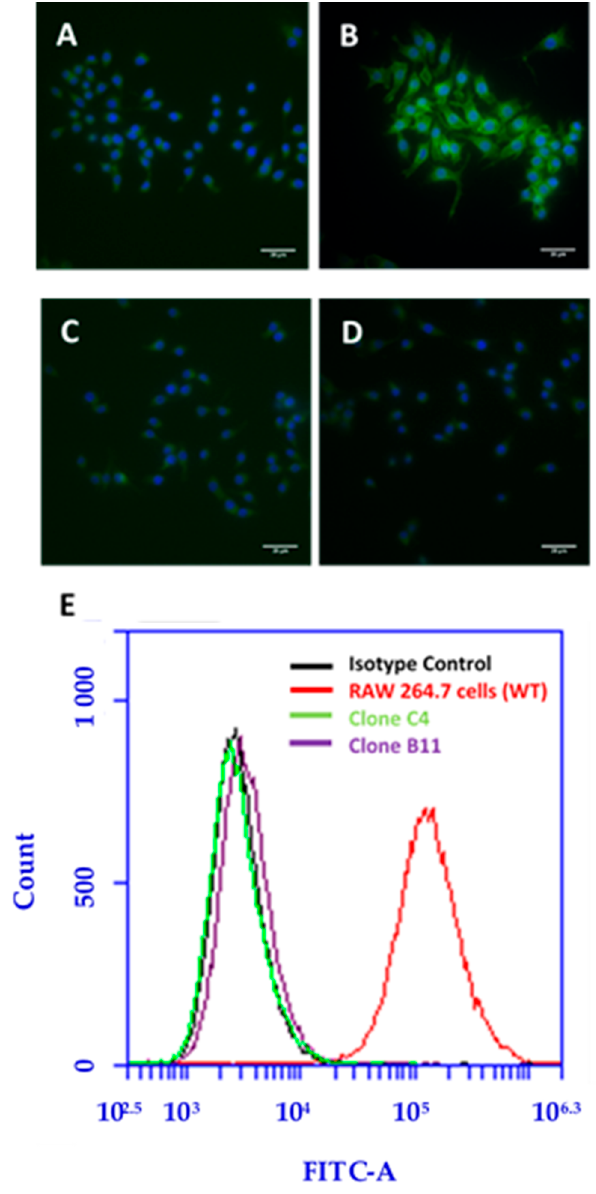
Figure 7. Immunofluorescence microscopy and flow cytometric analysis of WT and SR-A1 knockout RAW 264.7 cells. Immunofluorescence images of (A) control WT RAW 264.7 cells without mouse anti-SR-AI/MSR Alexa Fluor ® 488-conjugated antibody, (B) WT RAW 264.7 cells incubated with mouse anti SR-AI/MSR Alexa Fluor ® 488-conjugated antibody, and (C , D) two different clones (C4 and B11) of SR-A1 knockout RAW 264.7 cells incubated with anti-mouse SR-AI/MSR Alexa Fluor ® 488-conjugated antibody. Hoechst 33342 staining is shown in blue and Alexa Fluor ® 488 staining is shown in green. All images are normalized to the same intensity scale, and the scale bars represent 20 µm. (E) Flow cytometry analyses where the black line represents WT RAW 264.7 cells incubated with the rat IgG2B Alexa Fluor ® 488-conjugated monoclonal antibody as the isotype control, the red line represents WT RAW 264.7 cells incubated with mouse anti-SR-AI/MSR Alexa Fluor ® 488-conjugated antibody, and the green and purple lines represent two different clones (C4 and B11, respectively) of SR-A1 knockout RAW 264.7 cells incubated with mouse anti-SR-AI/MSR Alexa Fluor ® 488-conjugated antibody. The x-axis denotes fluorescence detected in the 518–548 nm spectral region, and the y-axis denotes the number of events for each analysis. To assess the recognition of BSA-pMWNTs and BSA-cMWNTs by SR-A1 receptors, the accumulation of 100 µg/mL BSA-coated pMWNTs or cMWNTs was measured using